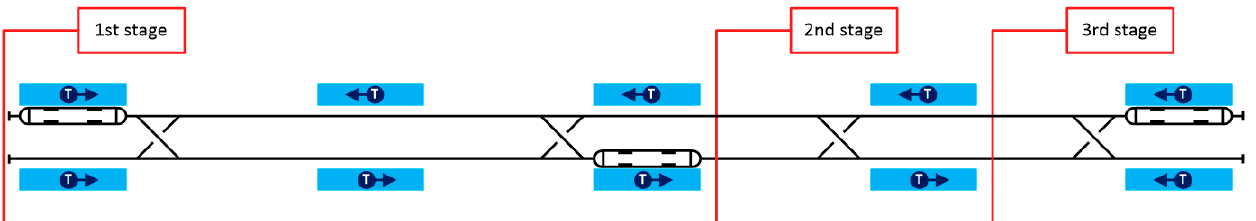
Figure 6. A bi-directional tram route commissioned in stages.